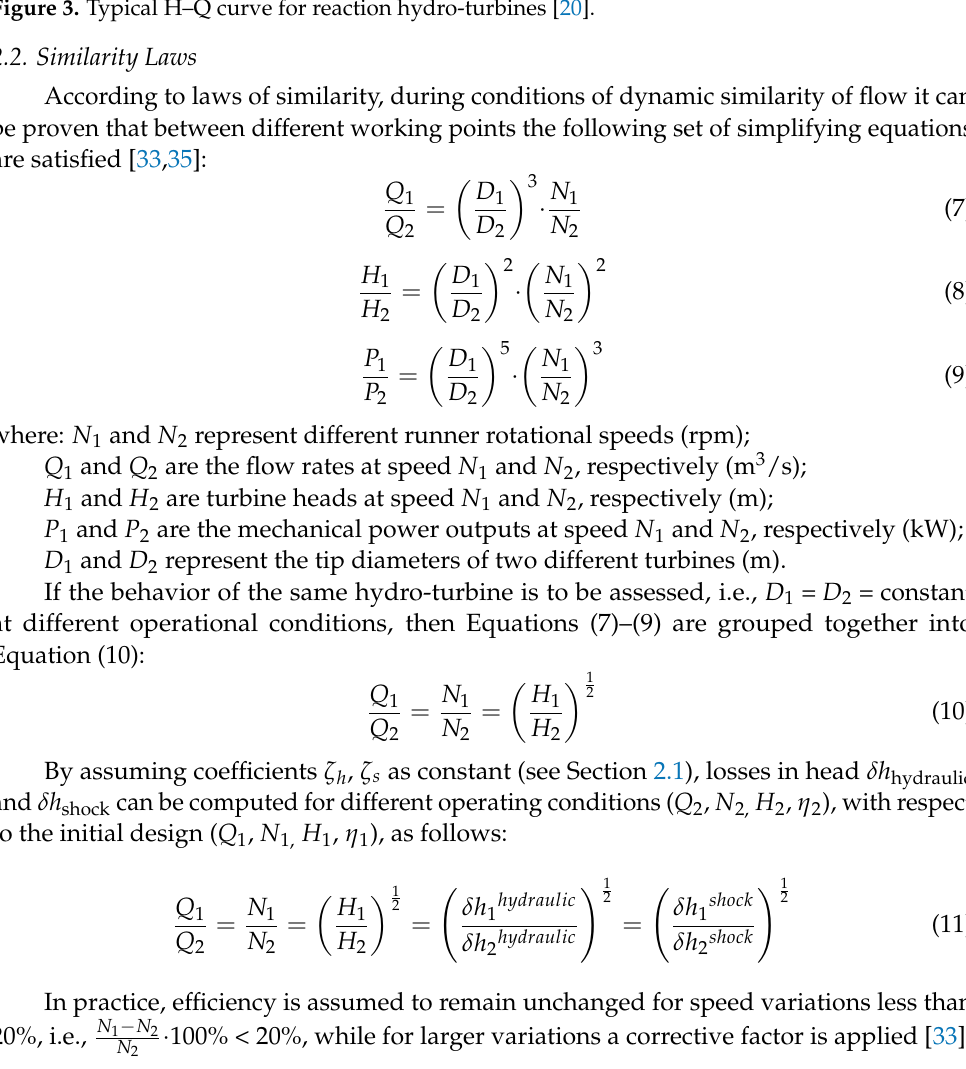
Figure 3. Typical H – Q curve for reaction hydro-turbines [20]. Figure 3. Typical H–Q curve for reaction hydro-turbines